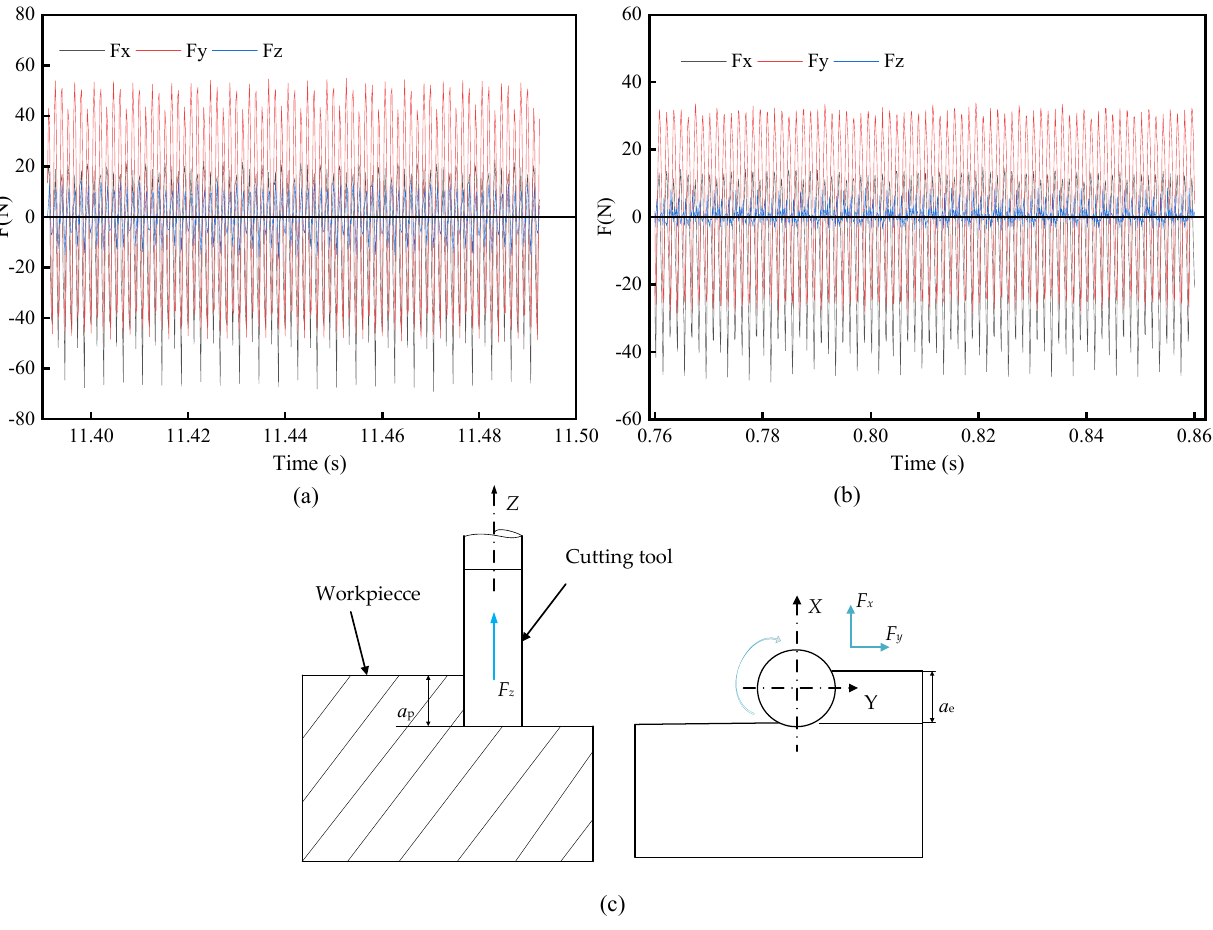
Figure 9. The original axial force signals during milling using ( a ) CCF-10 and ( b ) QC-2803; ( c ) cutting force direction.